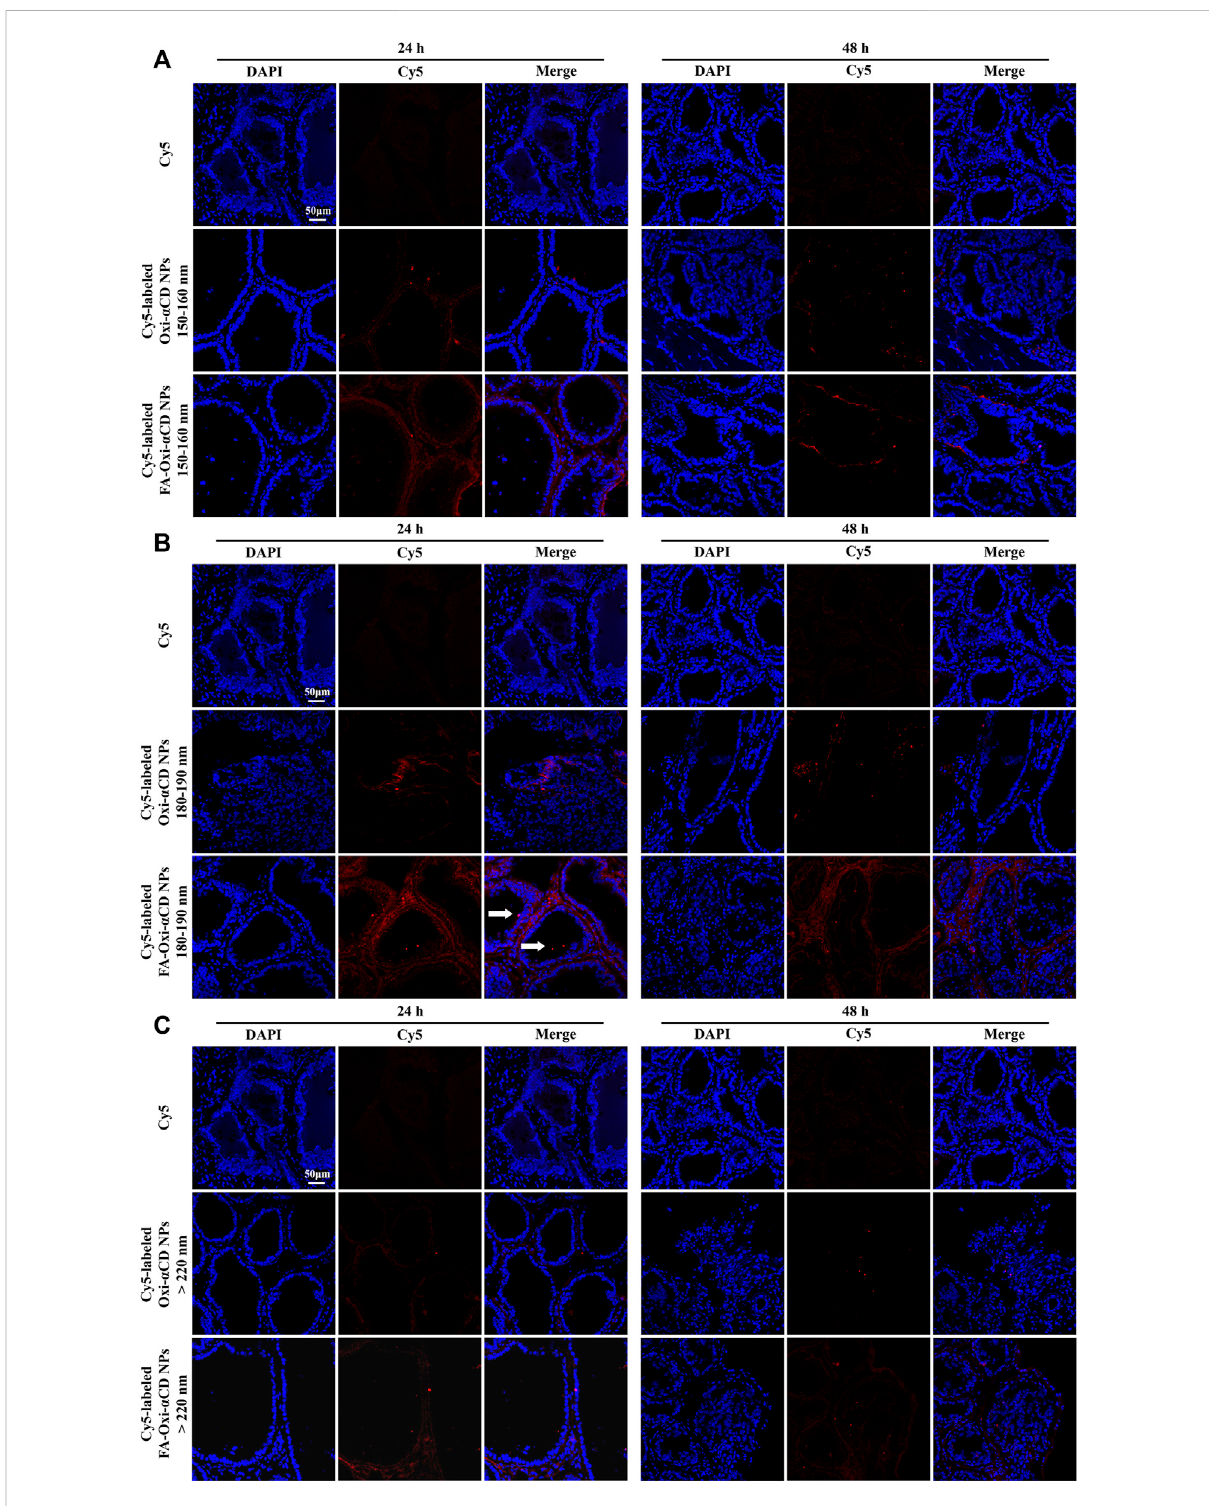
FIGURE 4 CLSM images of prostate tissues treated with Cy5 or Cy5-labeled NPs for 24 and 48 h. Red indicates NPs, and blue indicates DAPI. (A) 150 – 160 nm, (B) 180 – 190 nm and (C) > 220 nm. The scale bar represents 50 μ m.